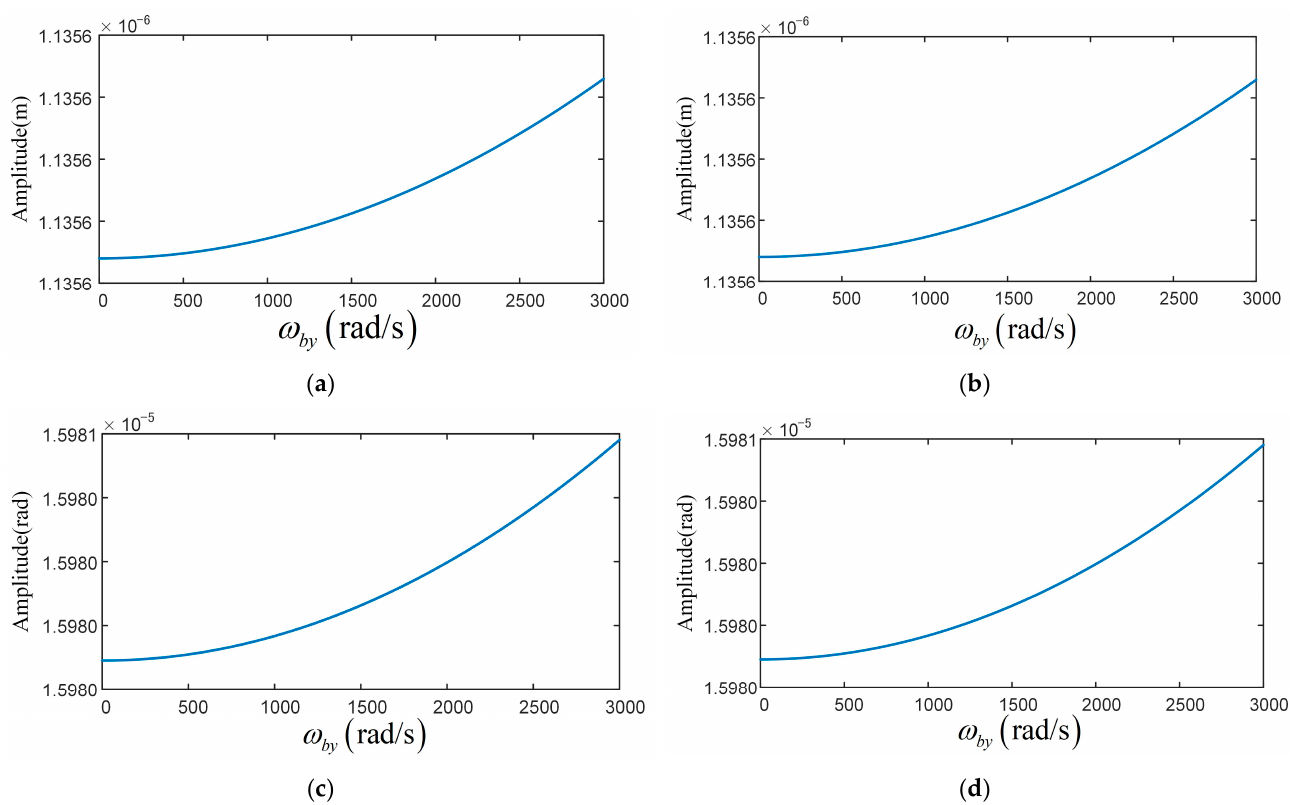
Figure 12. Responses of the dual-rotor system at disk 1 due to gravity with rolling base motion: ( a ) 𝑥 (cid:3031)(cid:2869) ; ( b ) 𝑧 (cid:3031)(cid:2869) ; ( c ) 𝜃 (cid:3031)(cid:2869) ; ( d ) 𝜓 (cid:3031)(cid:2869)